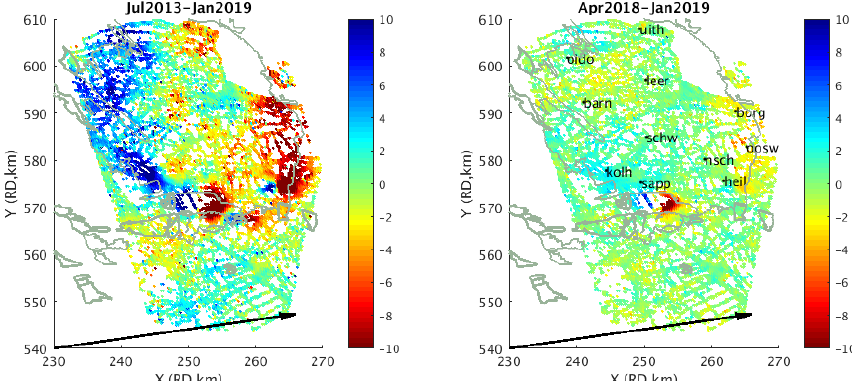
Figure 3. Horizontal deformation (mm) in the direction of the ascending look direction projected on the horizontal plane (arrow) for the time periods 2013–2019 and 2018–2019, including the location of the IGRS that are operational minimal from April 2018. The outlines of the gas fields are depicted in grey.